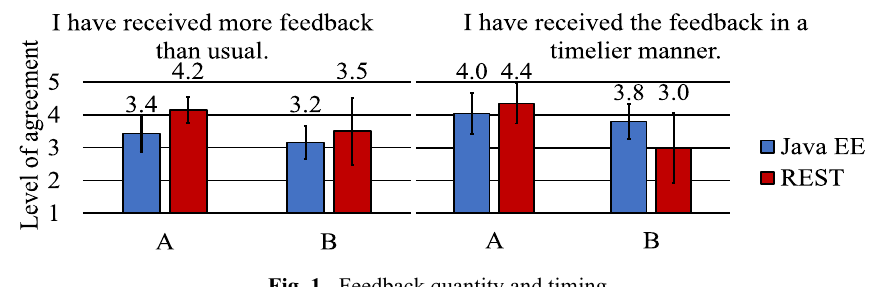
Fig. 1. Feedback quantity and